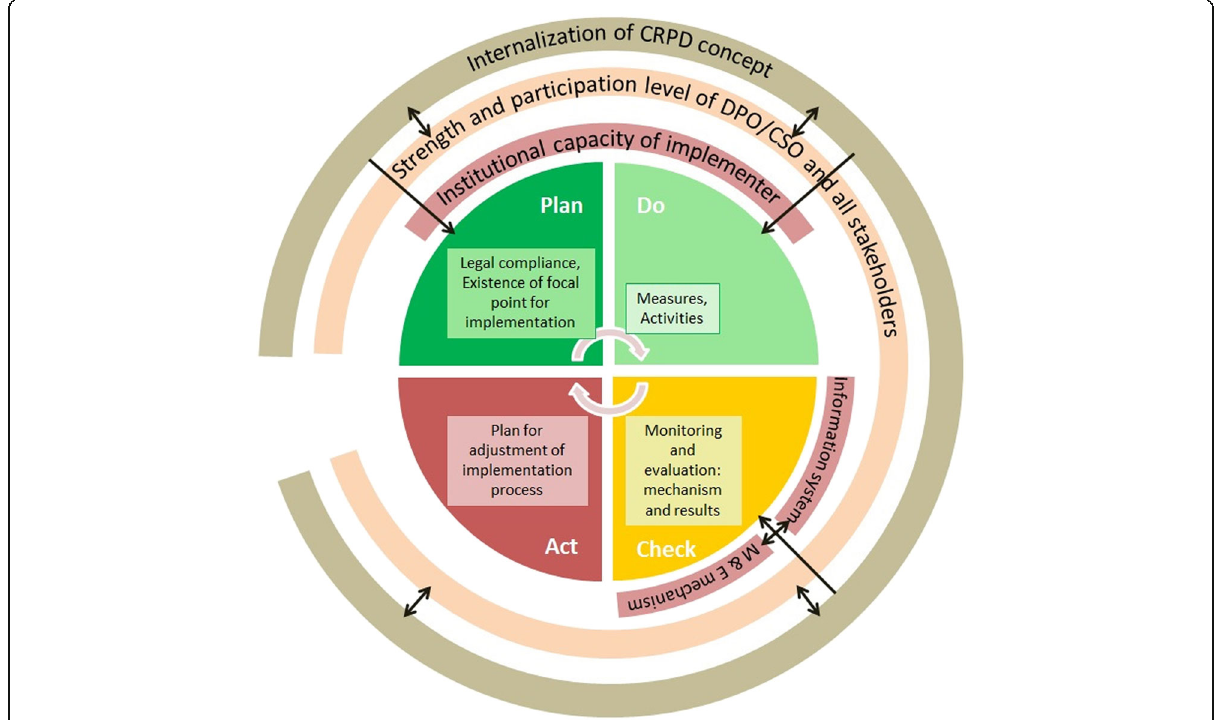
Fig. 2 Framework identifying factors affecting the implementation